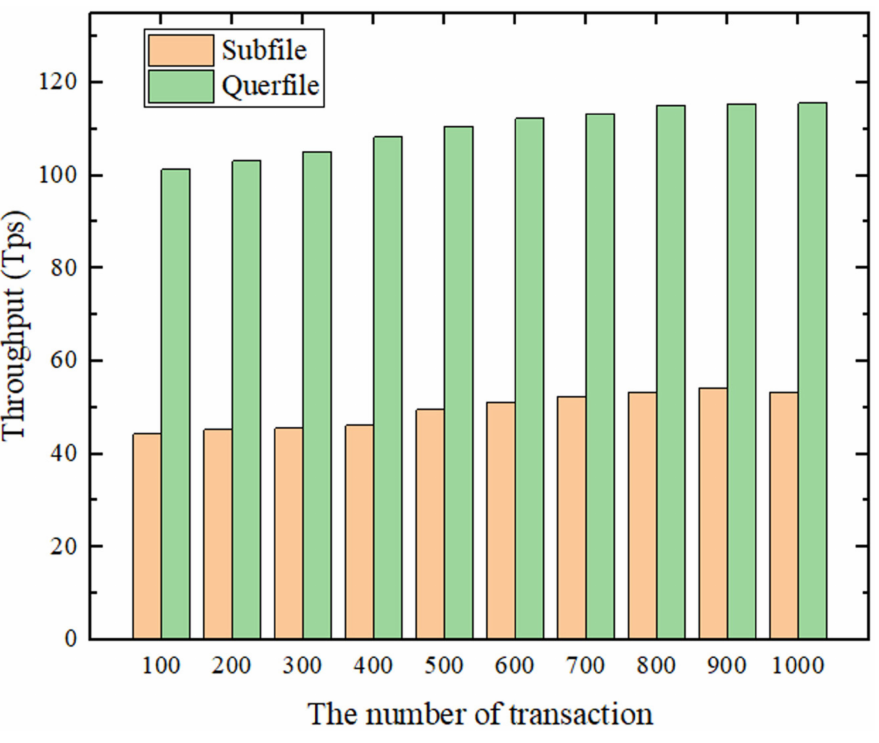
Figure 8. System throughput at different transaction volumes.